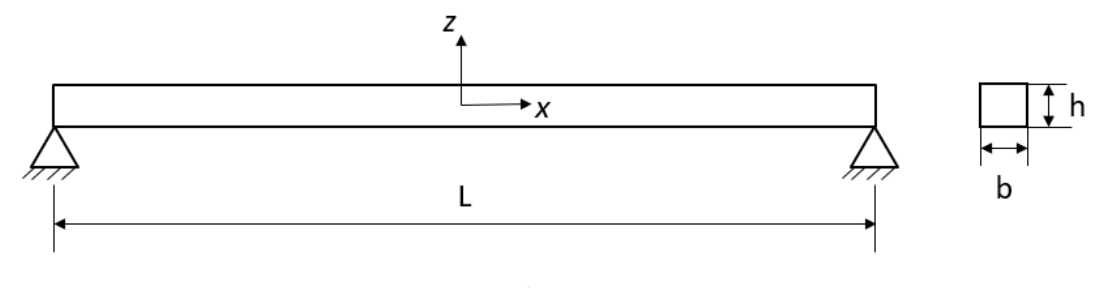
Figure 6. Beam schematic representation.